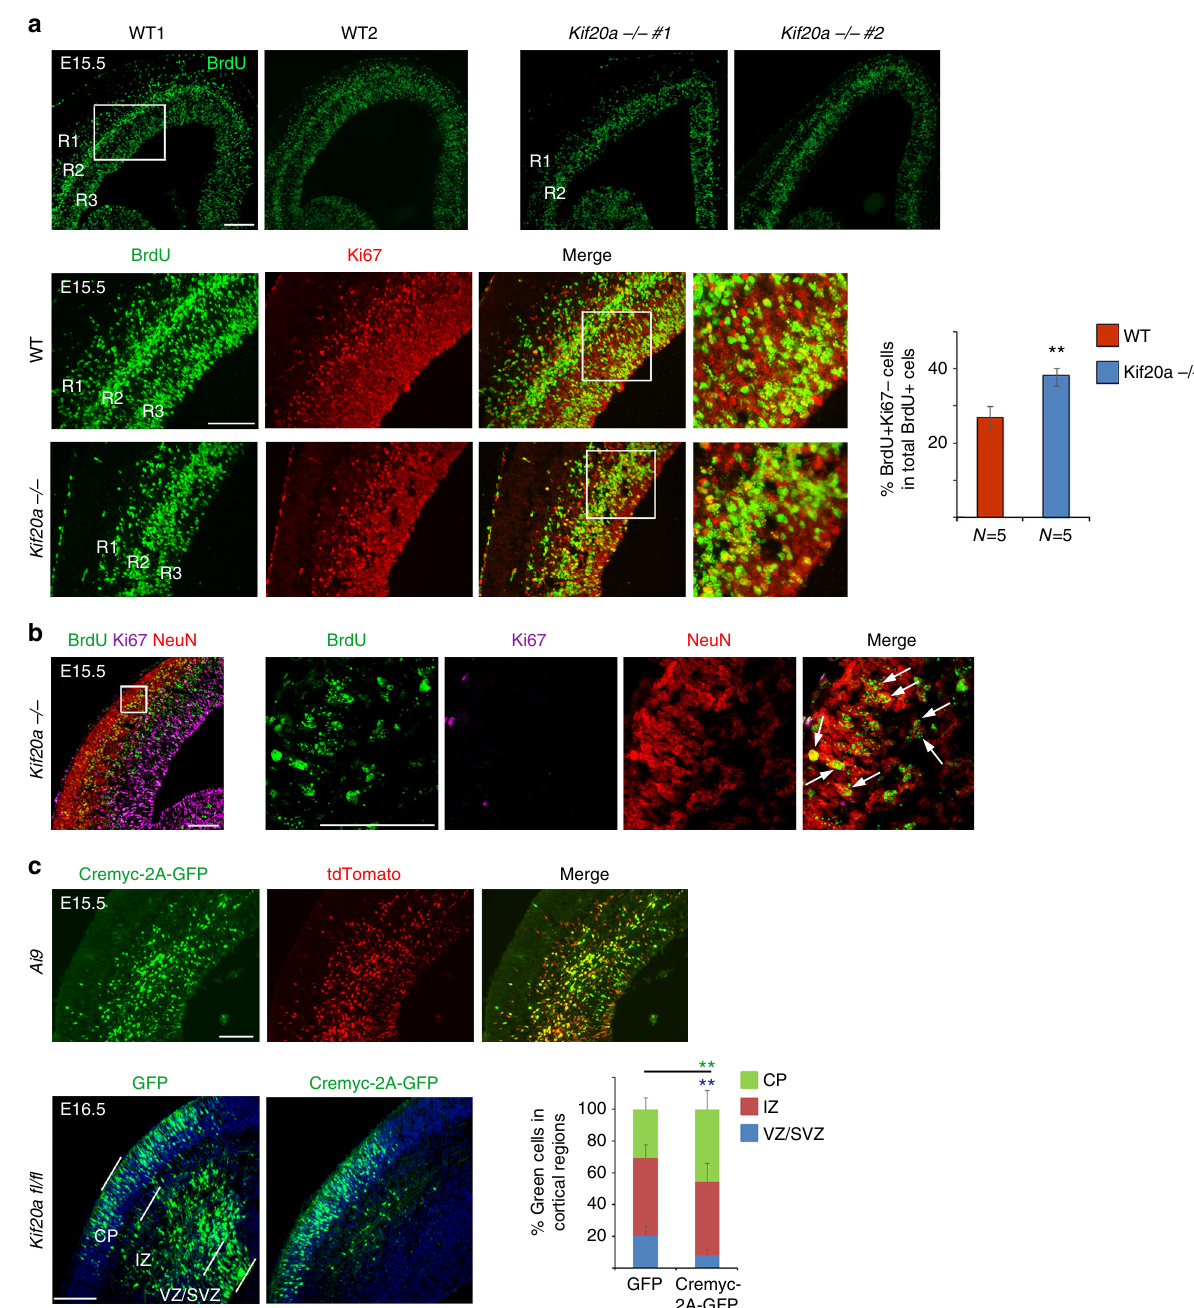
Fig. 7 Knockout of Kif20a causes early cell cycle exit and precocious neuronal differentiation. a BrdU was given to pregnant mouse at E14.5 and embryonic brains were collected 24 h afterwards. R1, R2, and R3 indicated the BrdU-labeled cell ribbons located progressively from super fi cial regions to apical surface. BrdU + Ki67 − cells were progenitor cells that had left the cell cycle. More BrdU + Ki67 − cells in the total population of BrdU + cells were present in the cortices of the Kif20a knockout- fi rst embryos. Scale bar represents 100 μ m. ** P < 0.01. Error bars represent SD. b BrdU + Ki67 − cells that had migrated into the cortical plate in the Kif20a knockout- fi rst cortex were positive for NeuN, indicating that these cells had become neurons. Arrows indicated examples of BrdU + Ki67 − NeuN + cells. Scale bar represents 100 μ m. c In the upper panel, CAG-Cremyc-2A-GFP plasmid was introduced into the cortices of Ai9 (loxP-STOP-loxP-tdTomato) reporter mice at E13.5 by IUE. Electroporated brains were harvested at E15.5 for analysis. Majority of Cre-expressing cells (GFP + cells) were positive for tdTomato expression, suggesting that Cre-mediated recombination was successfully carried out in these cells. In the lower panel, CAG-Cremyc-2A-GFP or control GFP plasmids were introduced into the cortices of Kif20a fl / fl conditional knockout mice by IUE at E13.5 and the brains were analyzed at E16.5. Distributions of transfected cells in different radial regions of the cortex were scored. Scale bar represents 100 μ m. The symbol ** (in green and blue font) indicates P < 0.01 with respect to the CP and VZ/SVZ distributions comparing to control GFP. Error bars represent SD. CP: cortical plate, IZ: intermediate zone, VZ/SVZ: ventricular/subventricular zone. Scale bar represents 100 μ